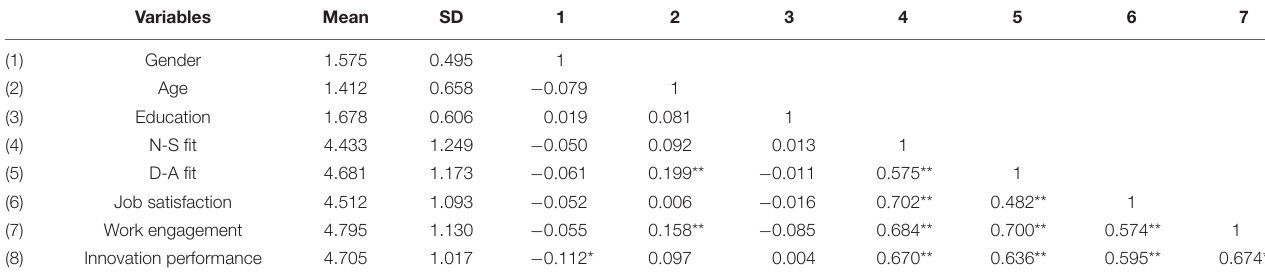
TABLE 2 | Means, standard deviations, and correlations among the study variables.